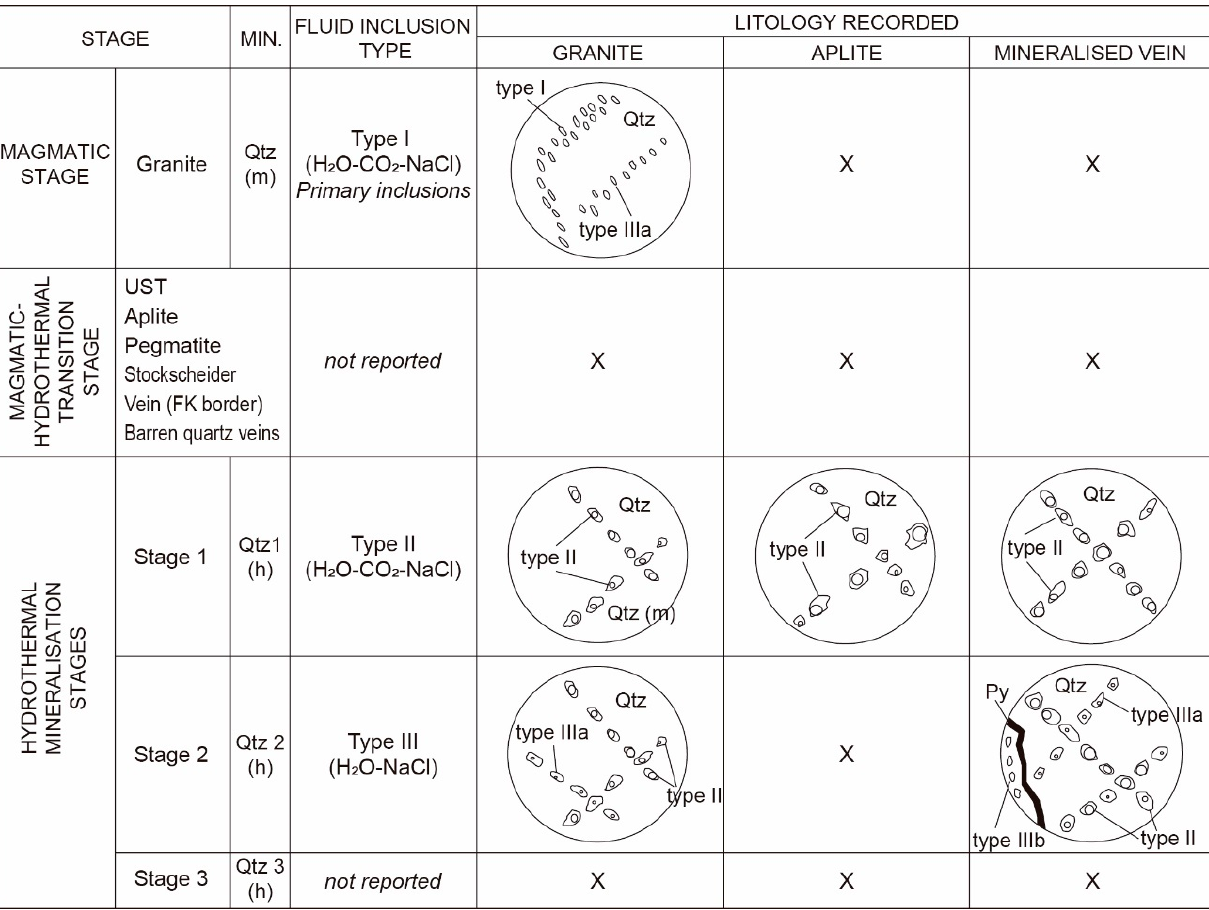
Figure 16. Synthetic sketch and paragenetic table showing the relationships and the distribution of the different types of fluid inclusions in the studied samples of the Barreiro zone relative to magmatic–hydrothermal transition. Primary fluid inclusions (type I) are found in magmatic quartz in the host granite; type II fluid inclusions occurs in granite, aplite, as well as in the mineralised quartz vein; types IIIa and IIIb are observed in the granite and mineralised quartz veins. Abbreviations: